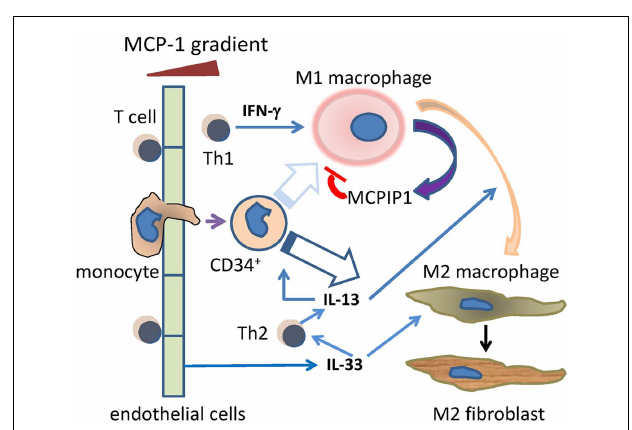
FIGURE 7 | Schema of theTh1/M1 andTh2/M2 responses after cells move through blood vessel endothelium . Monocytes andT cells migrate through endothelium, initially in response to MCP-1, and including a primitive (CD34 + ) monocyte.TheTh1 product IFN- γ drives the migrated monocytes toward the M1 phenotype, although this may be less likely for the CD34 + subset (faded arrow). MCP-1 itself induces migrated activated macrophages to secrete MCPIP1 (MCP-1-induced protein-1), which limits the activated M1 phenotype. During that initialTh1/M1 phase,Th2 activities such as the secretion of IL-13 begin, and become dominant at later time points.This may be aided by endothelial cell secretion of IL-33. IL-13 may promote some M1–M2 transition as well as direct monocyte to M2 maturation.The resulting M2 macrophages can become collagen-secreting myeloid